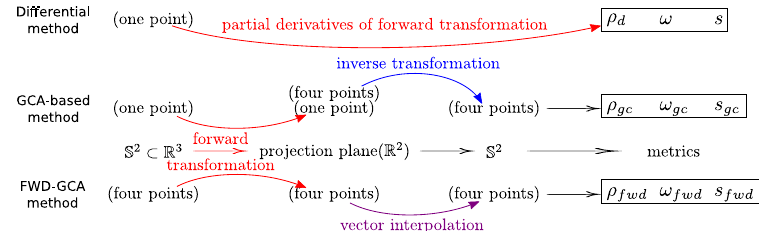
Figure 2. Comparison of differential, GCA-based, and FWD–GCA-based methods.